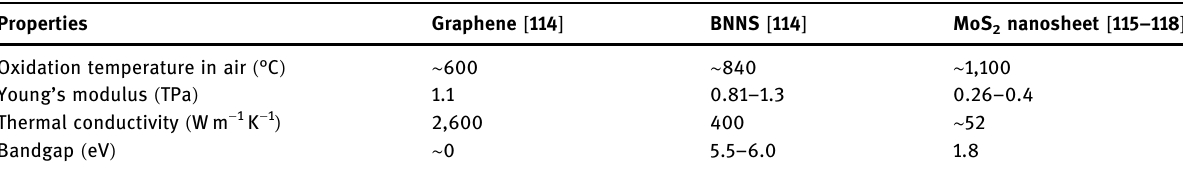
Table 2: Properties of graphene, BNNS, and MoS 2 nanosheet Properties